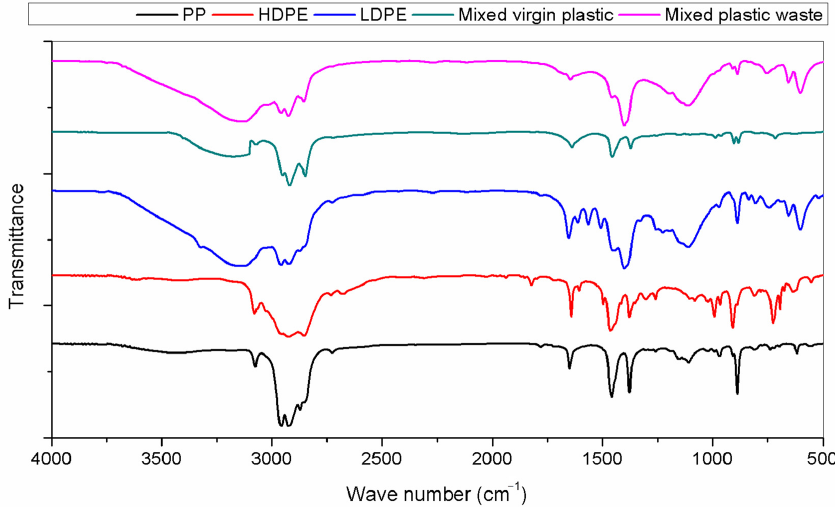
Figure 6. FTIR spectra of liquid hydrocarbon fuel from pyrolysis of LDPE, HDPE, PP, MVP, and DPW.